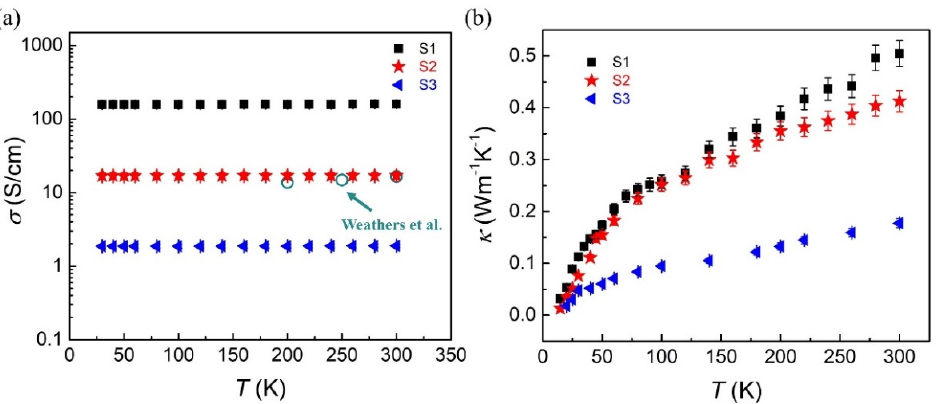
Figure 3. ( a ) the axial electrical conductivities of S1, S2, and S3 nanofibers, which exhibit a slight enhance as the temperature increase from 20 K to 300 K. The length of the S1, S2, and S3 are 20.3 μ m, 15.7 μ m, and 15.3 μ m and the diameter of the S1, S2 and S3 are 160 nm, 171 nm, and 138 nm, respectively. The dark green circles represent the increased trend of electrical conductivity of PEDOT:PSS fiber in previous result [20]; ( b ) the axial thermal conductivities of three samples in- crease as the temperature increase. The increasing trend of thermal conductivity proved that PE- DOT:PSS nanofibers are amorphous dominated molecular